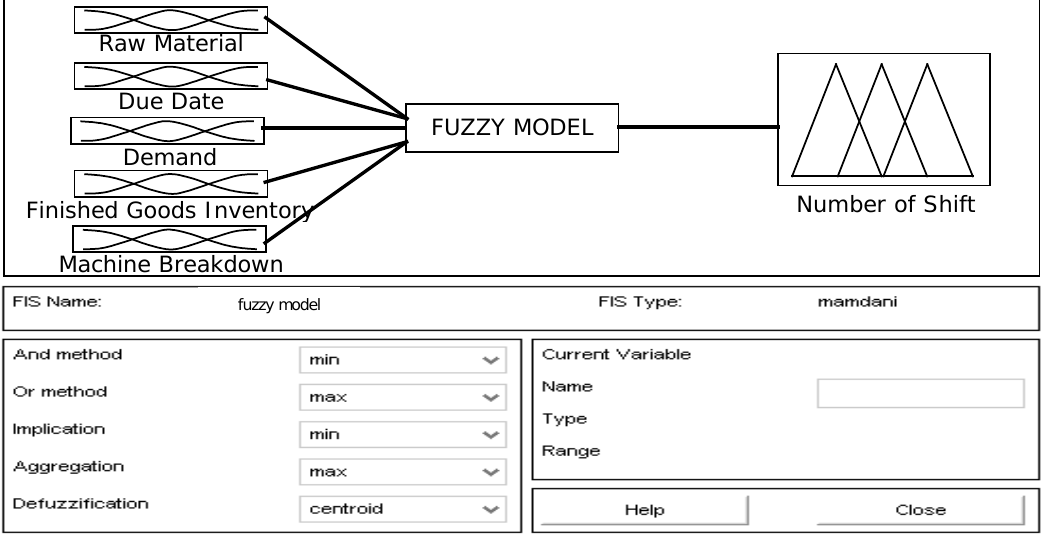
Figure 3. “FIS model for Number of Shift”. Source: Own